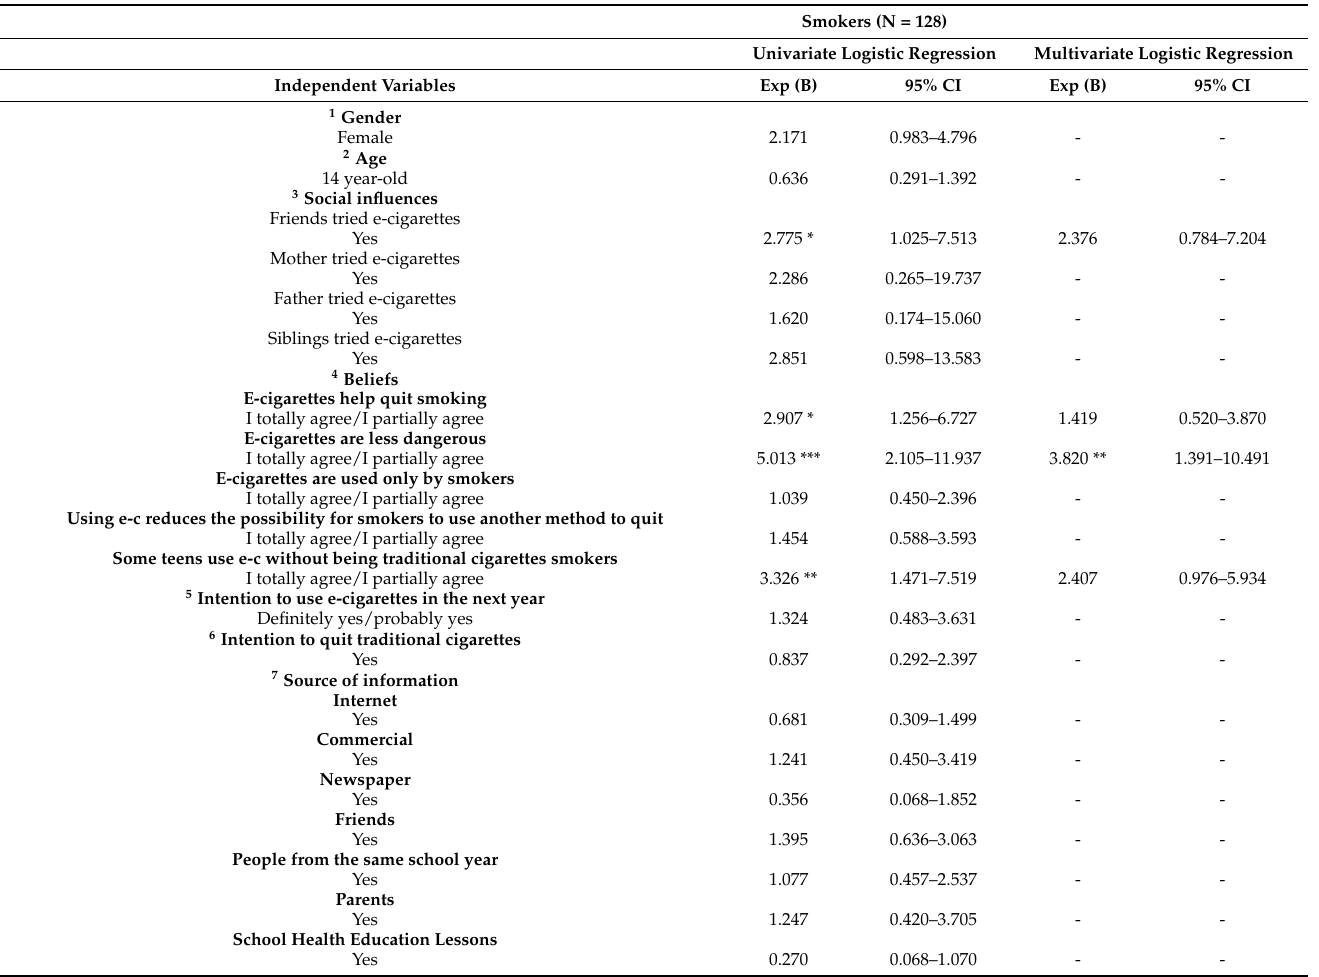
Table 4. Correlates of ever trying e-cigarettes: results of univariate and multivariate logistic regression among smokers. Smokers (N = 128) Univariate Logistic Regression Multivariate Logistic